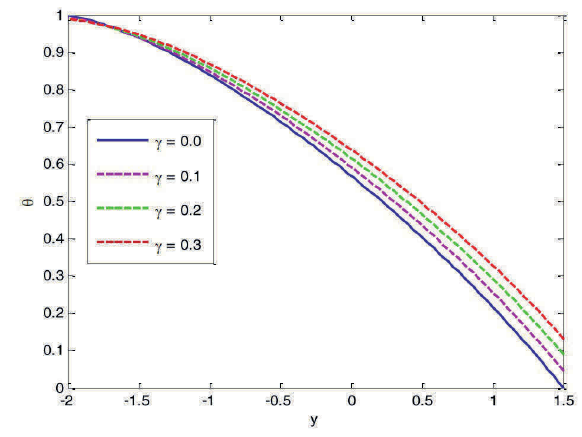
Fig. 20: Impact of Schmidt number Sc on